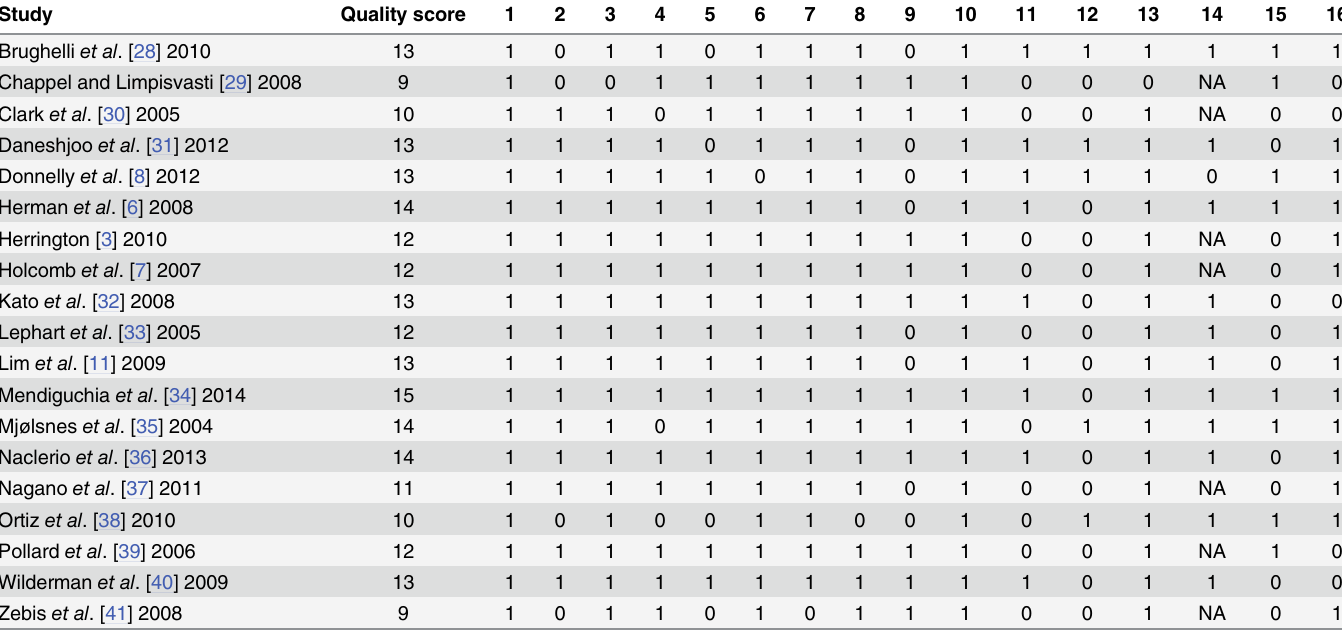
Table 2. Quality assessment of the included